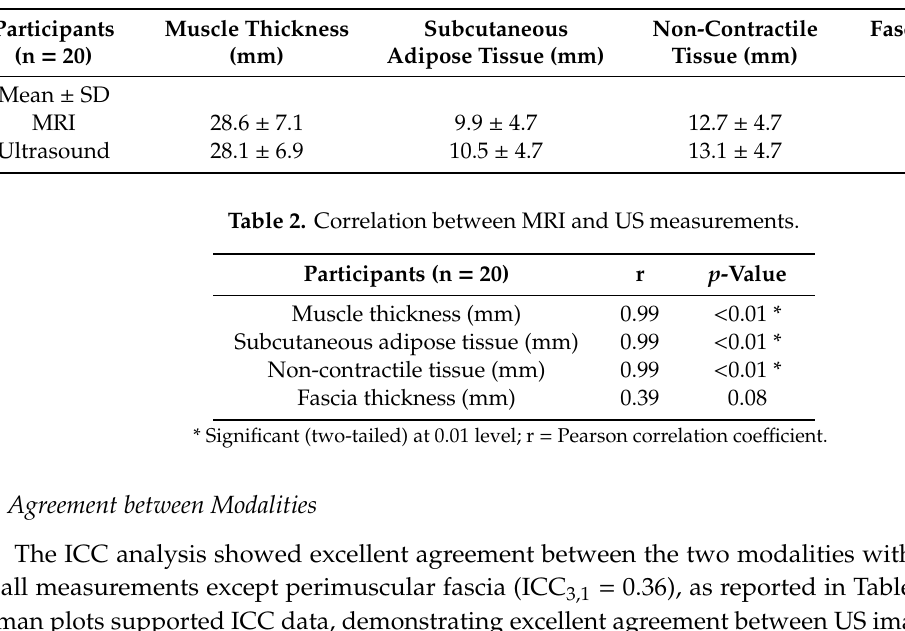
Table 1. Thickness of di ff erent tissue measurements on MRI and US.